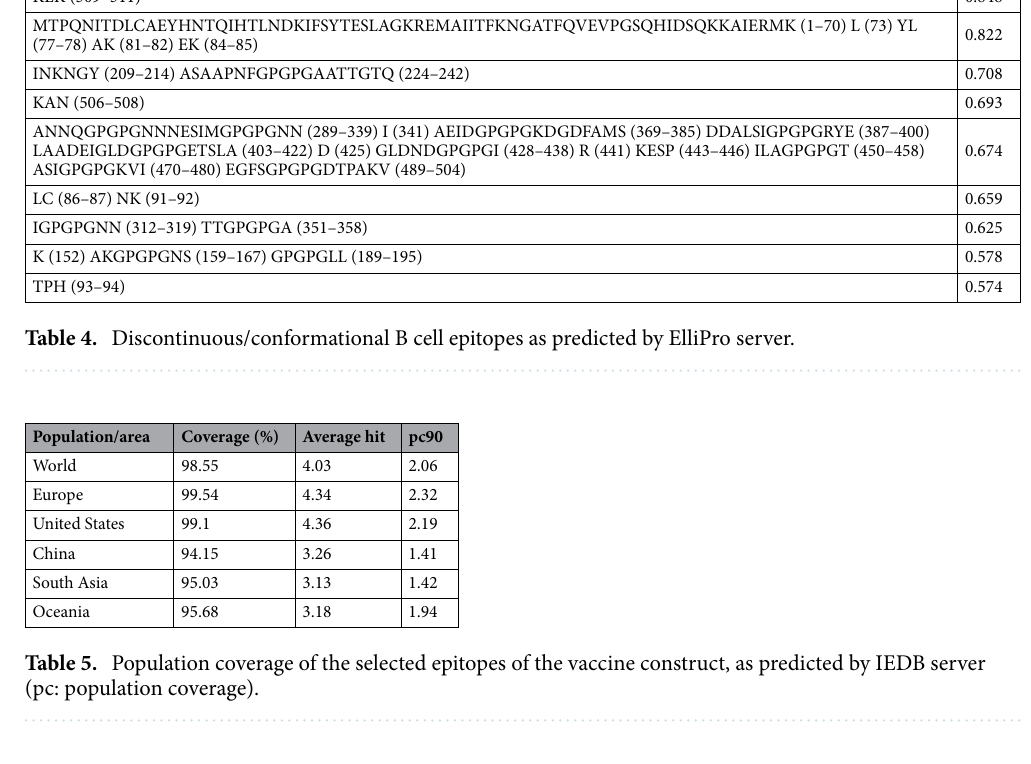
Discontinuous epitopes